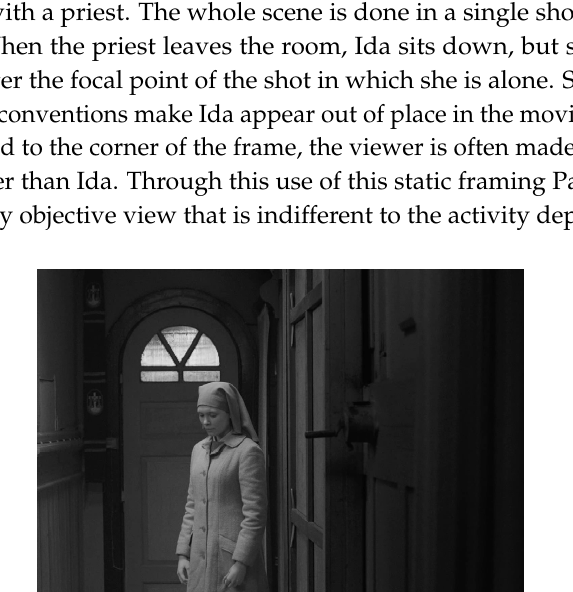
Figure 15. Later in the scene with unbalanced framing.